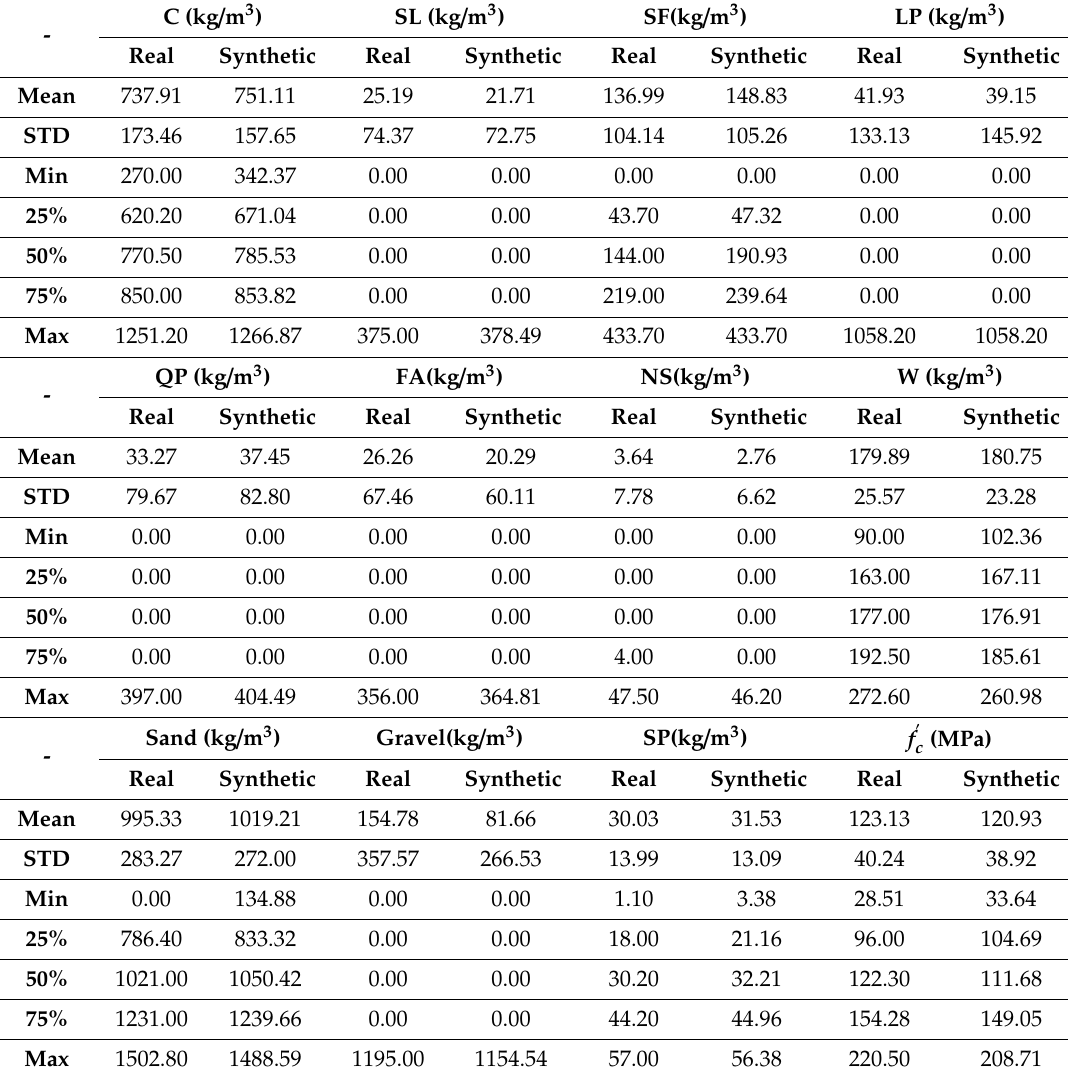
Table 3. Statistical comparison of real data and synthetic